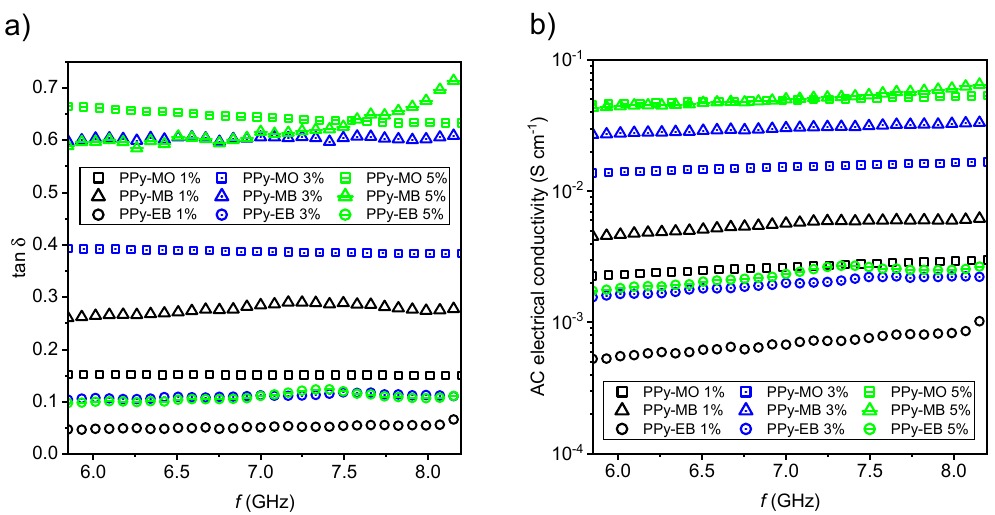
Figure 4. ( a ) Dielectric loss tangent of prepared PPy 1D structures and ( b ) related AC electrical conductivity (samples prepared at 25 °C, various loadings).